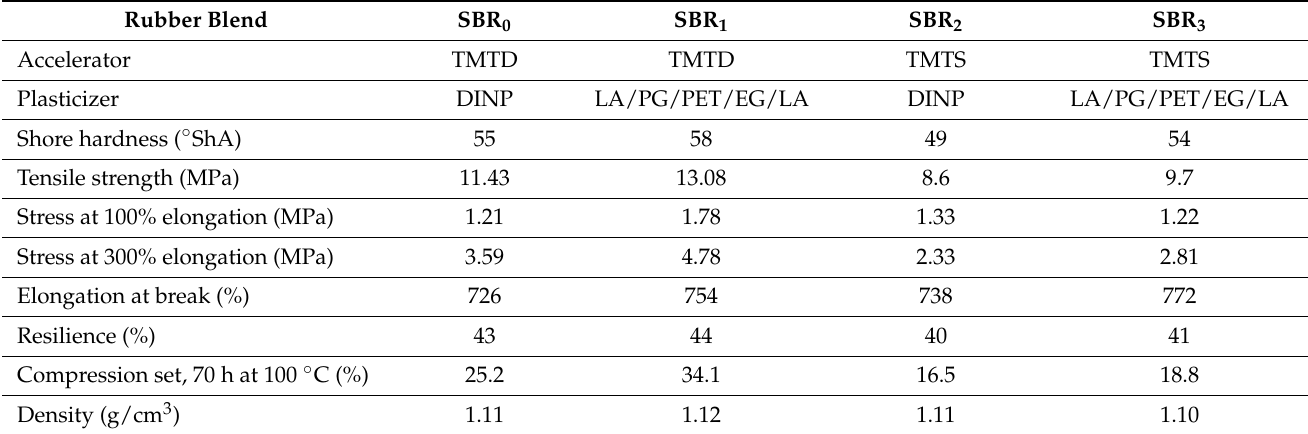
Table 11. The mechanical properties of SBR after vulcanization at 170 ◦ C for 15 min.